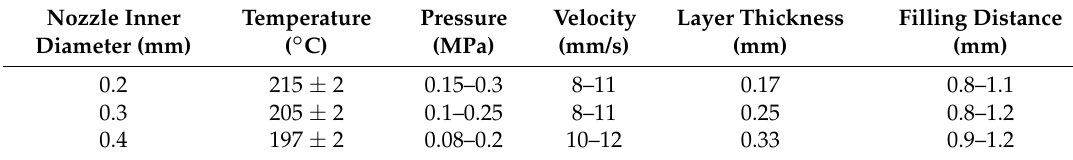
Table 1. Various printing parameters of the PLGA